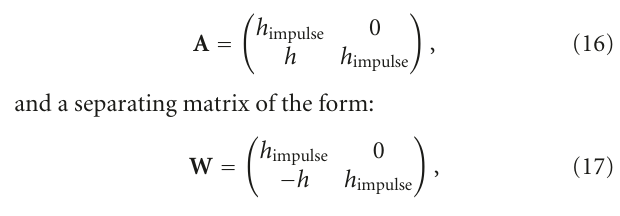
Figure 11, with a mixing matrix of the